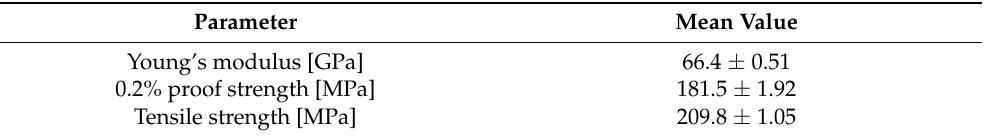
Table 3. Mean values of Young’s modulus, the 0.2% proof strength and the tensile strength of the AW-6060 T6 aluminium alloy